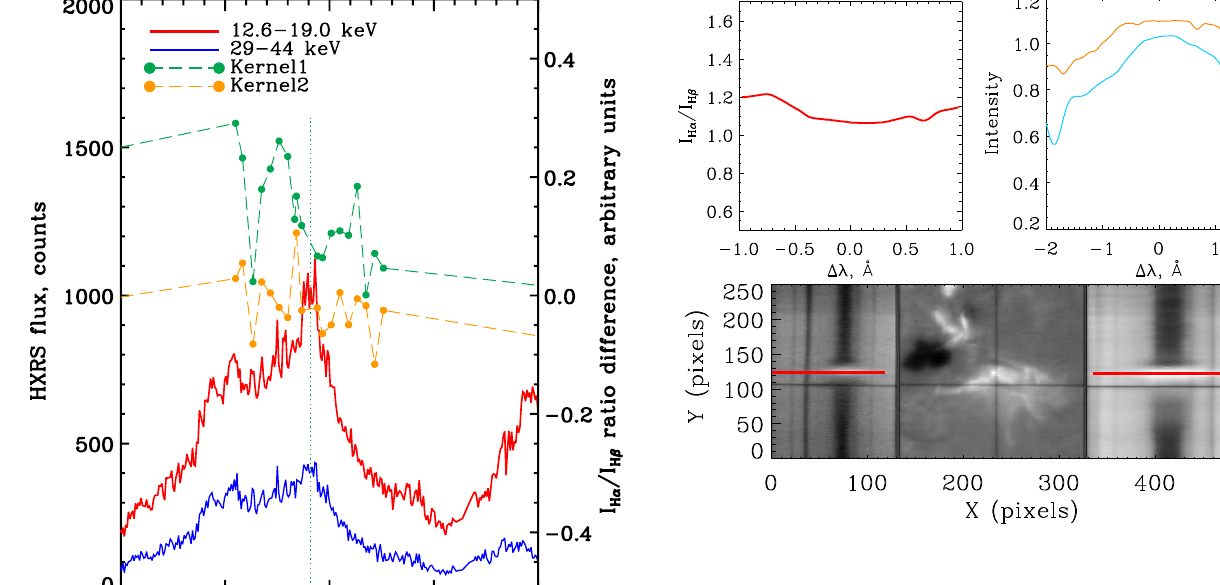
Fig. 12. Top: left – H α /H β ratio profiles for kernel 3 at 10:06:00UT. Right – H α (orange solid line) and H β (light green- blue solid line) profiles at the position marked at the bottom com- posed picture. Intensity of each line is related to the local contin-